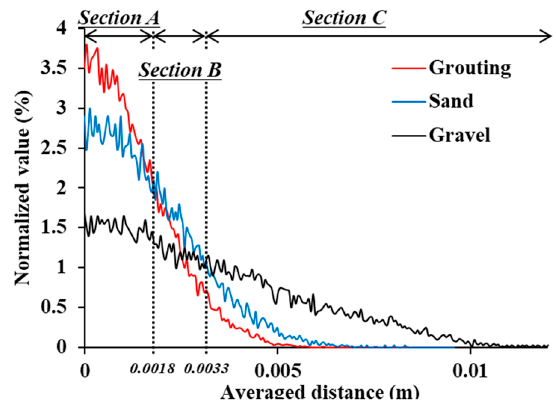
Figure 9. Normalized histogram for three samples.